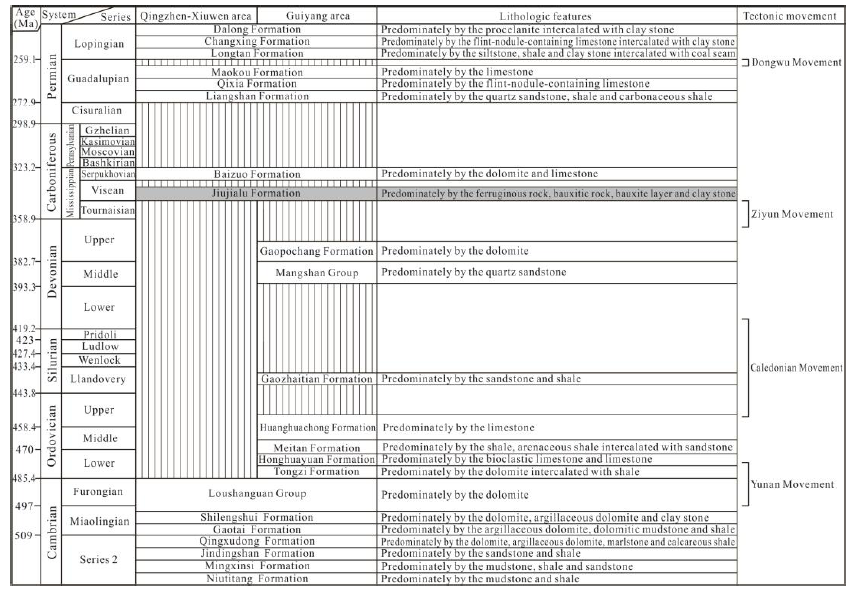
Figure 2. Paleozoic stratigraphic sequences in central Guizhou area (modified from [28]).